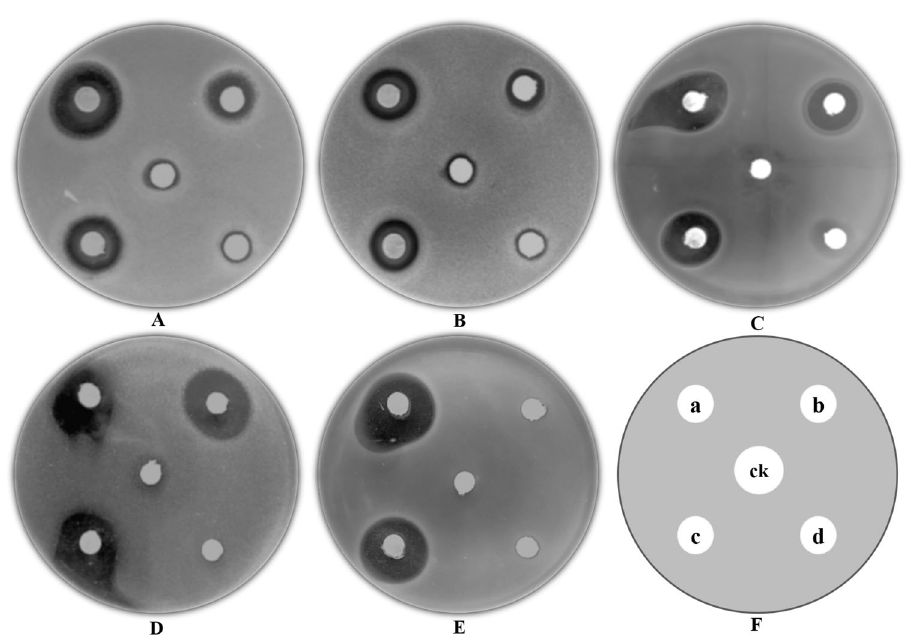
Figure 8. Antimicrobial activity of silver nanoparticles against various pathogenic bacterial strains shown by filtering paper diffusion method [( A ) E. coli ATCC8099; ( B ) S. aureus ATCC6538; ( C ) B. subtilis ATCC6051;